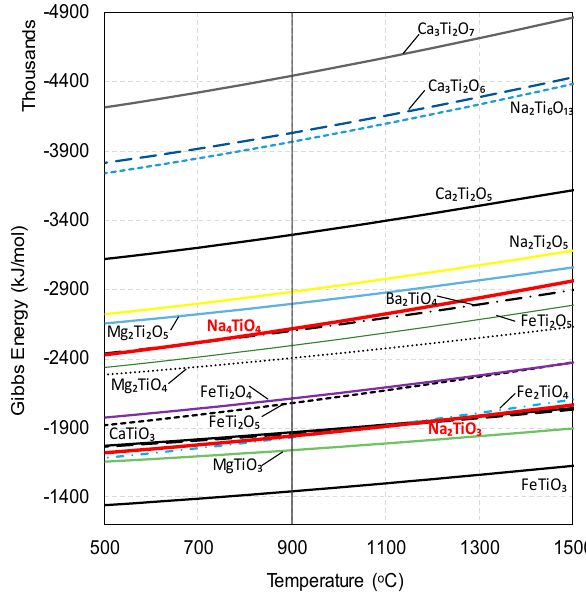
Figure 2. Comparison of Gibbs free energy of phase formation of several titanate species throughout the temperature range by Factsage 7.0™ database, with calcium titanate being most favourable.